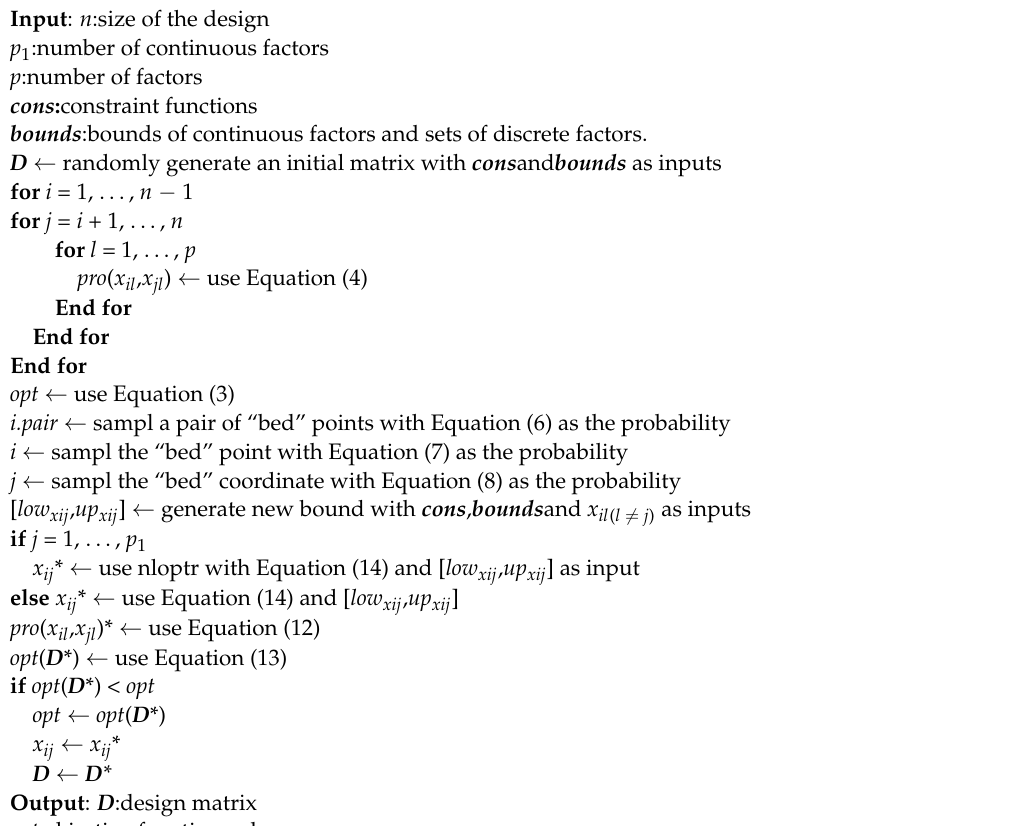
Algorithm 1 MaxPro